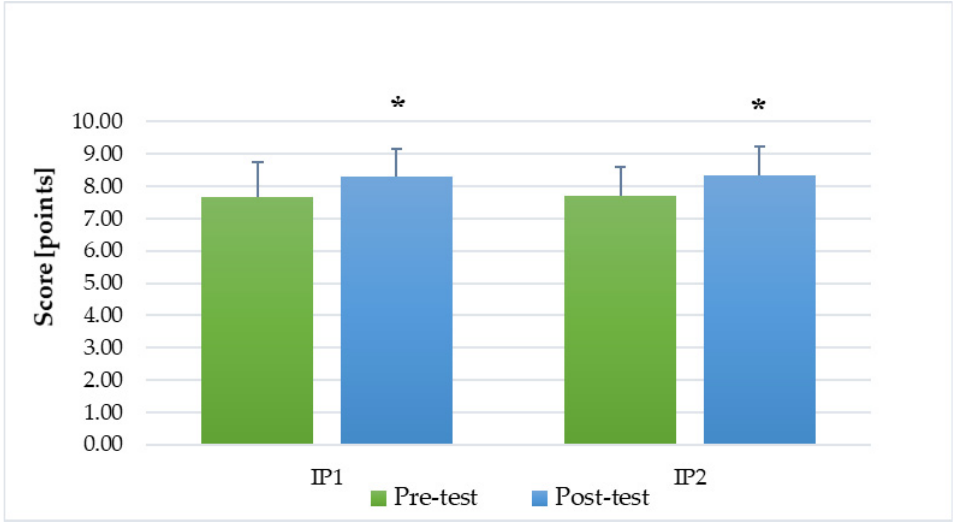
Figure 5. Comparison of the changes in final scores in IP1 and IP2. * p ≤ 0.05.